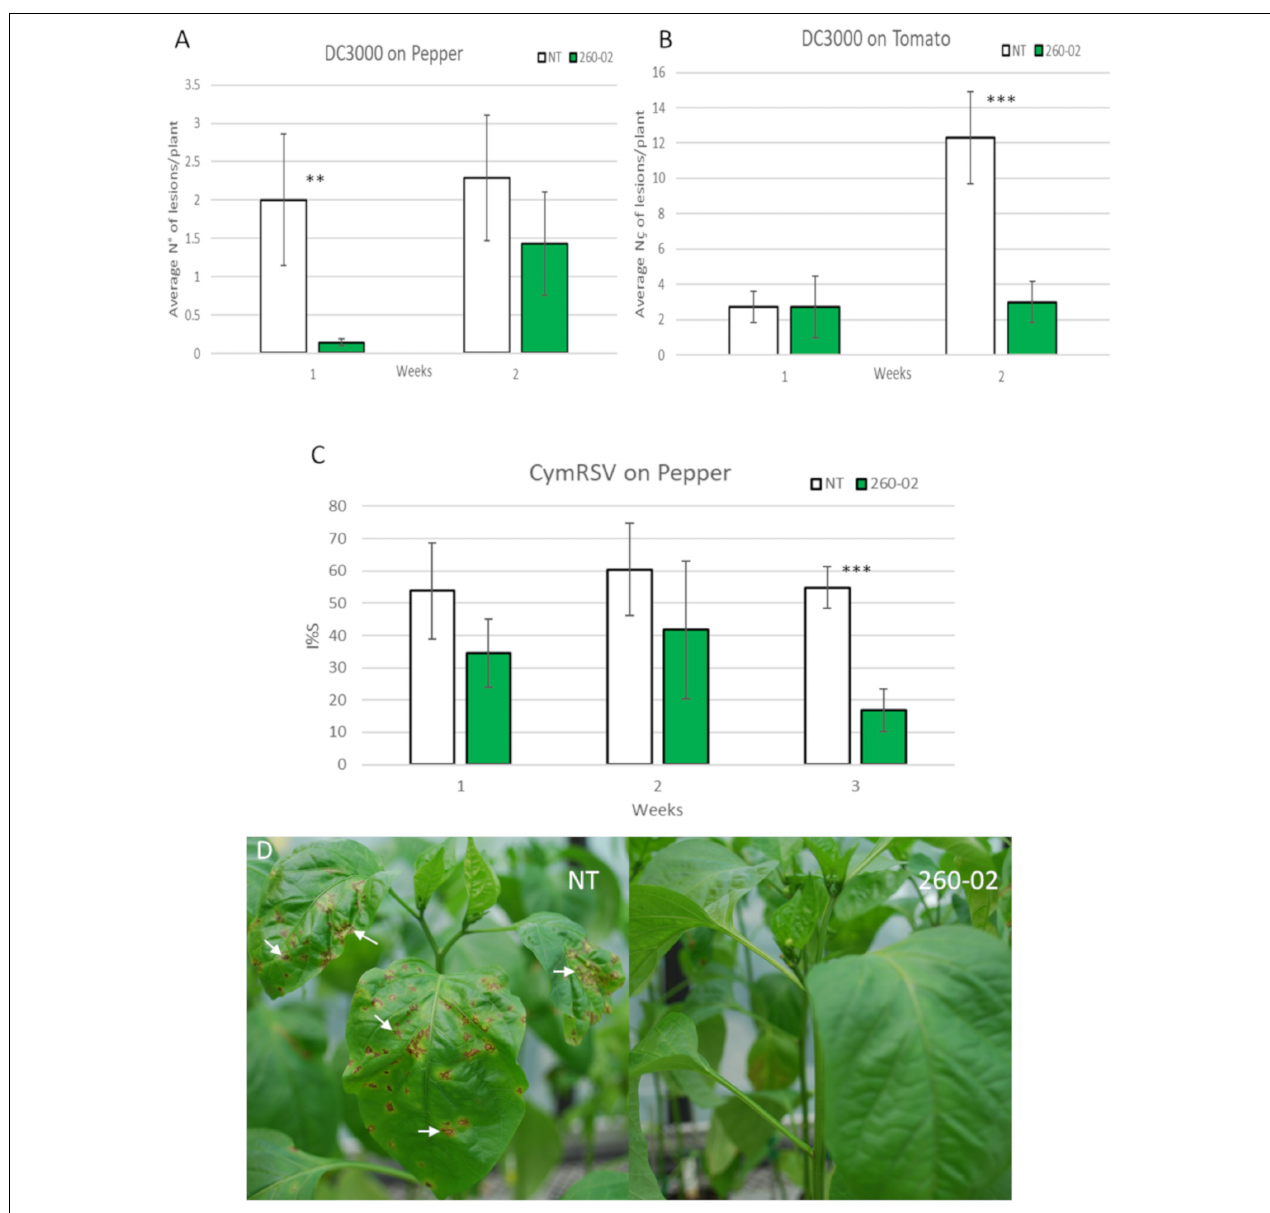
FIGURE 5 | Results of the in planta biocontrol assays. Green bars indicate the plants that were treated with strain 260-02 by root dipping 2 weeks (for biocontrol against DC3000) or one month (for biocontrol against Cymbidium Ringspot Virus ) before being challenged with the pathogen, while white bars indicate non-treated control plants. For each combination of treatment, pathogen, and host, 7 biological replicates were used. (A) graph reporting the number of lesions developed by P. syringae strain DC3000 on pepper plants; (B) graph reporting the number of lesions developed by P. syringae strain DC3000 on tomato plants. The vertical axis shows the average number of lesions per plant, on the horizontal axis are divided the observations 1 and 2 weeks after inoculation with the pathogen. Statistically different results according to the Student’s T -test are reported with asterisks ( ∗ p < 0.05; ∗∗ p < 0.01; ∗∗∗ p ≤ 0.001). (C) graph reporting the percentage infection index (I%I) registered on pepper plants inoculated with Cymbidium Ringspot Virus (CymRSV). Statistically different results according to Student’s T -test are reported with asterisks ( ∗ p < 0.05; ∗∗ p < 0.01; ∗∗∗ p ≤ 0.001). (D) Pictures of representative plants that were inoculated with CymRSV: typical symptoms of the disease can be seen on the leaves of the non-treated plant, with evident circular necrotic spots; the plants also inoculated with strain 260-02 show fewer or, as reported in the picture, no symptoms on newer